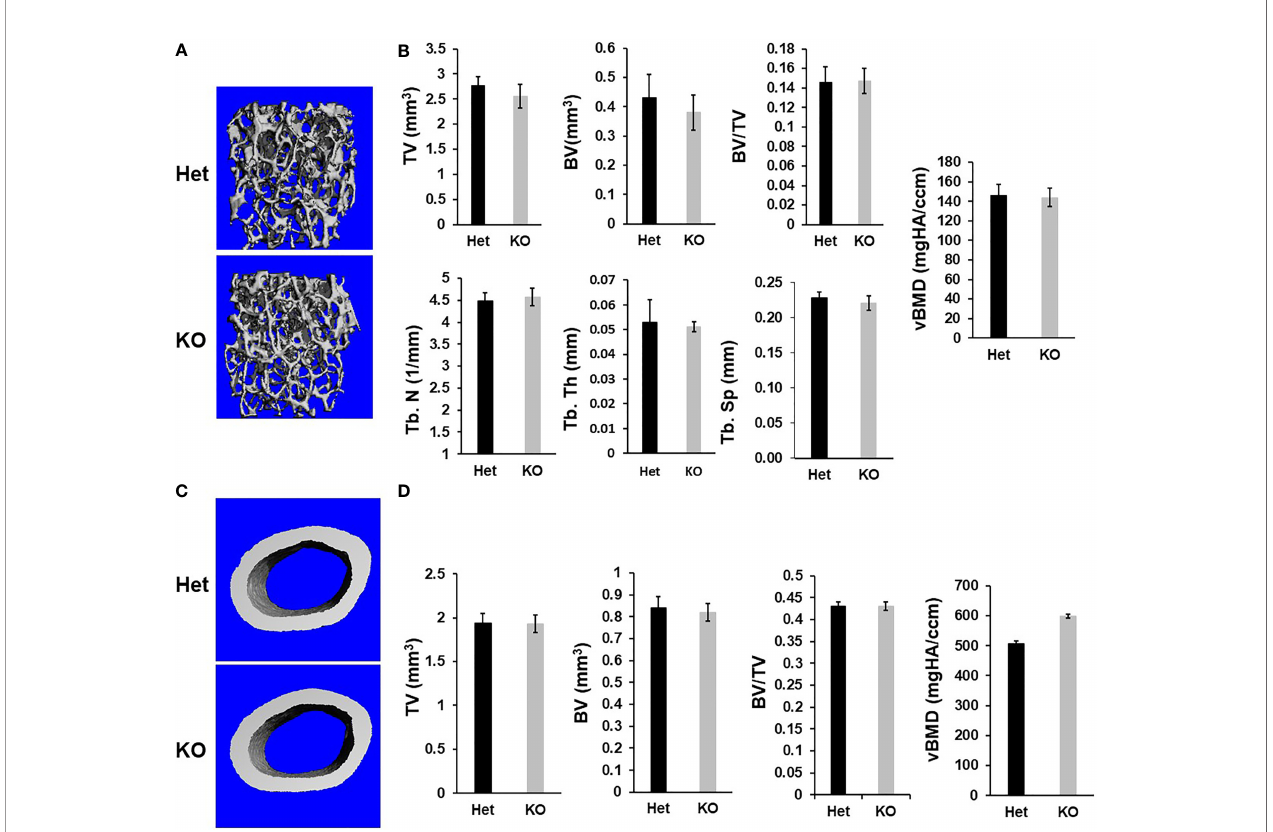
FIGURE 2 | Micro-CT analyses reveals no changes in trabecular and cortical parameters of the femur of the Cldn12 cKO mice at 13 weeks of age. (A) Micro-CT images of the trabecular bone of the distal femur of the KO and control heterozygous mice. (B) Quantitative micro-CT data of the trabecular bone of the distal femur. (C) Micro-CT images of the cortical bone of the KO and control heterozygous mouse femurs. (D) Quantitative micro-CT data of the cortical bone of the femur. TV, tissue volume; BV, bone volume; Tb. N, trabecular number; Tb.Th, trabecular thickness; Tb.Sp, trabecular spacing; vBMD, volumetric bone mineral density. Values are Mean ± SEM (n=8, 4 males and 4